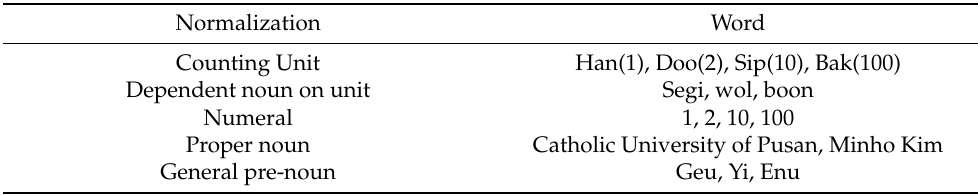
Table 5. Normalization of words using the part-of-speech information.